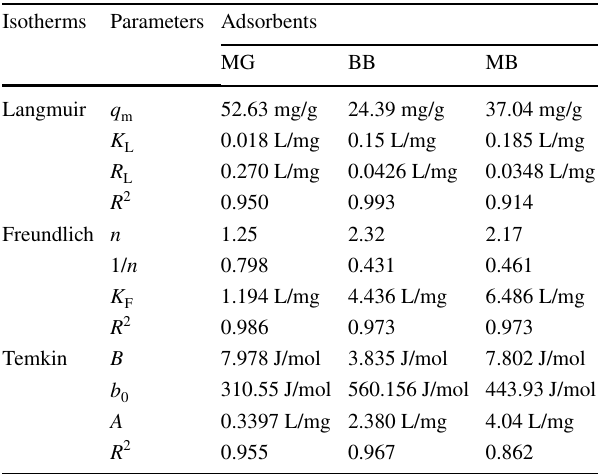
Table 1 Isotherm parameters for the adsorption of Zn(II) onto mag- netite, baobab and